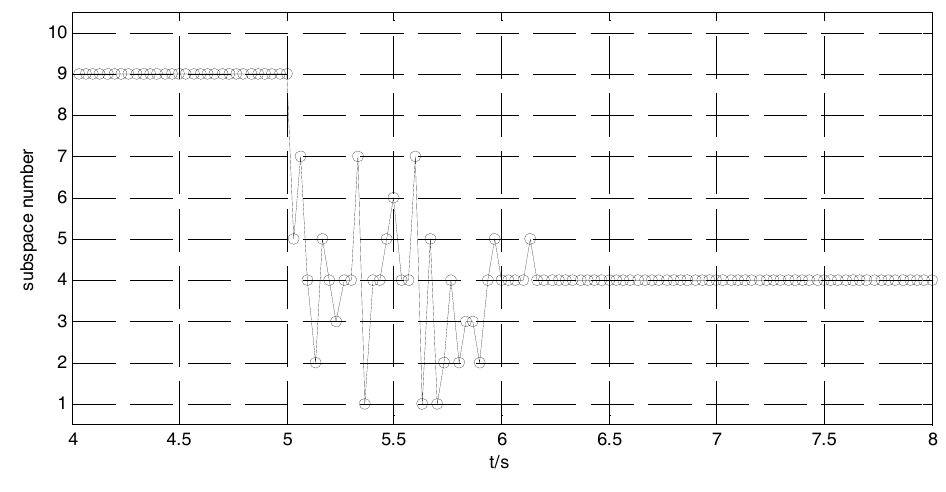
Figure 11. Output trajectory of the CART.